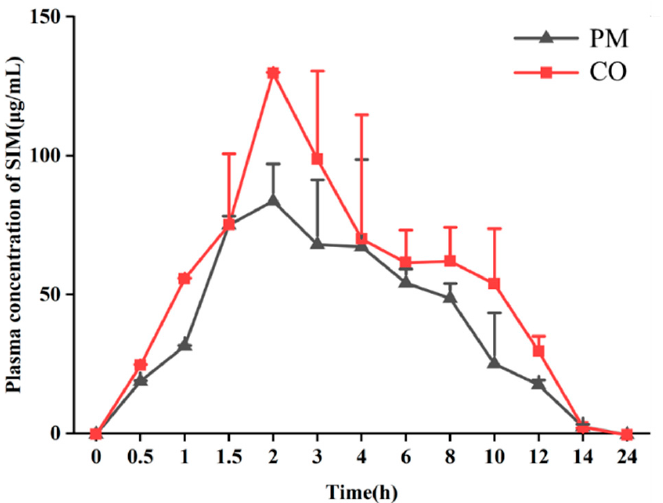
Figure 6. Powder dissolution profiles of SIM-EZE CO and PM in 60% ethanol. ( A ) EZE in the CO and PM. ( B ) SIM in the CO and PM.